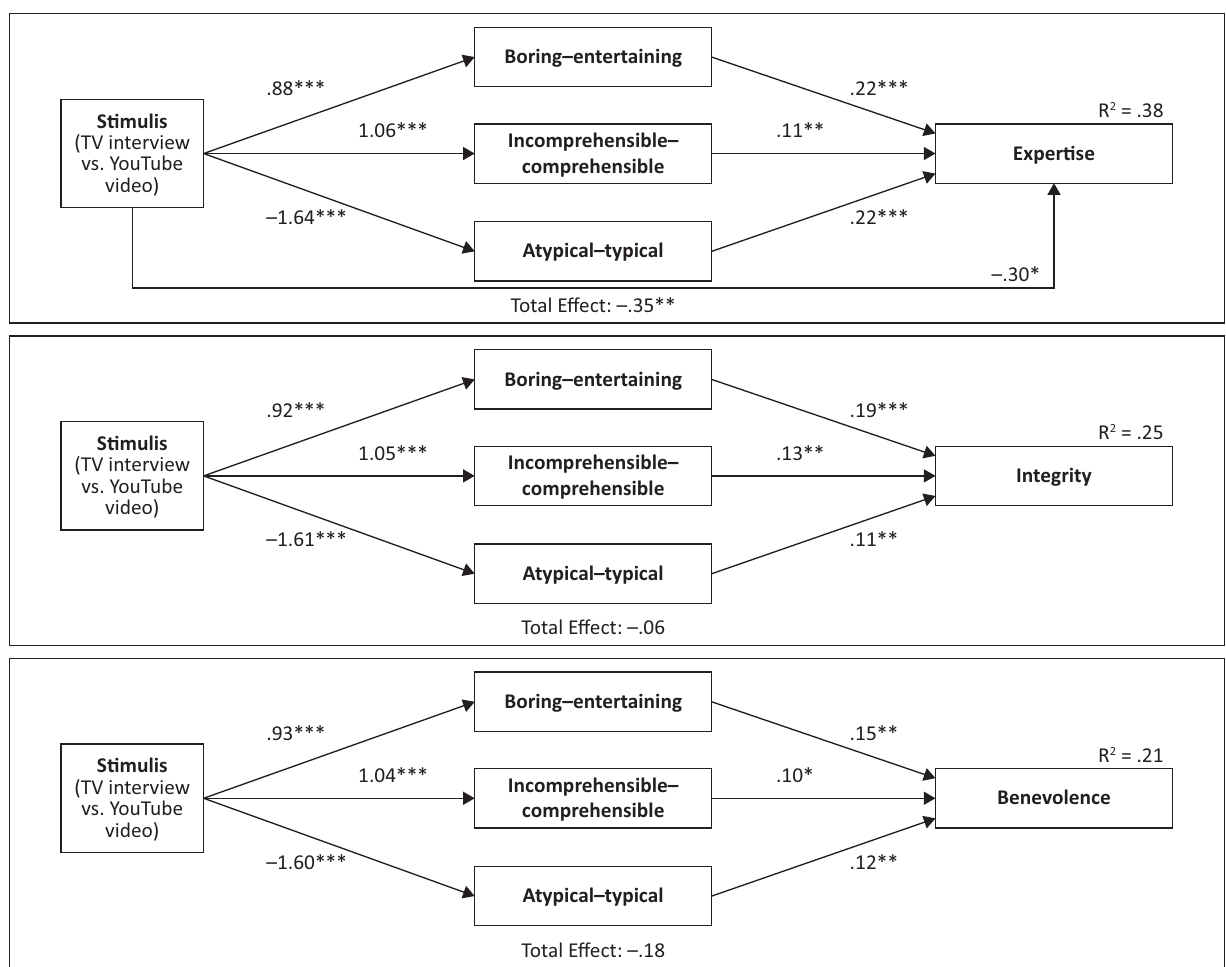
Figure 2. Mediation models for direct and indirect effects of stimulus on perceived trustworthiness. Notes: Unstandardised coefficients are reported, *p ≤ .05, **p ≤ .01, ***p ≤